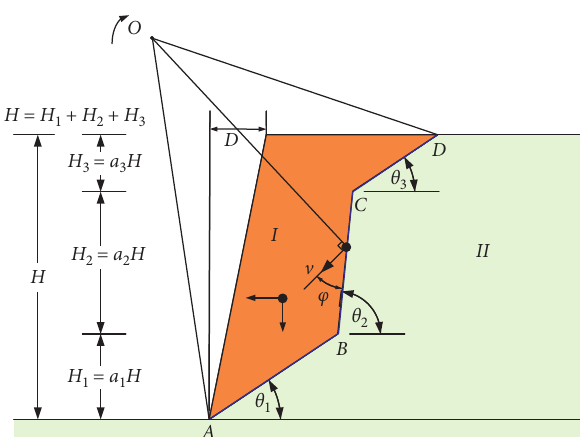
Figure 11: Simplified schematic diagram of the three-fold line fracture surface and wedge